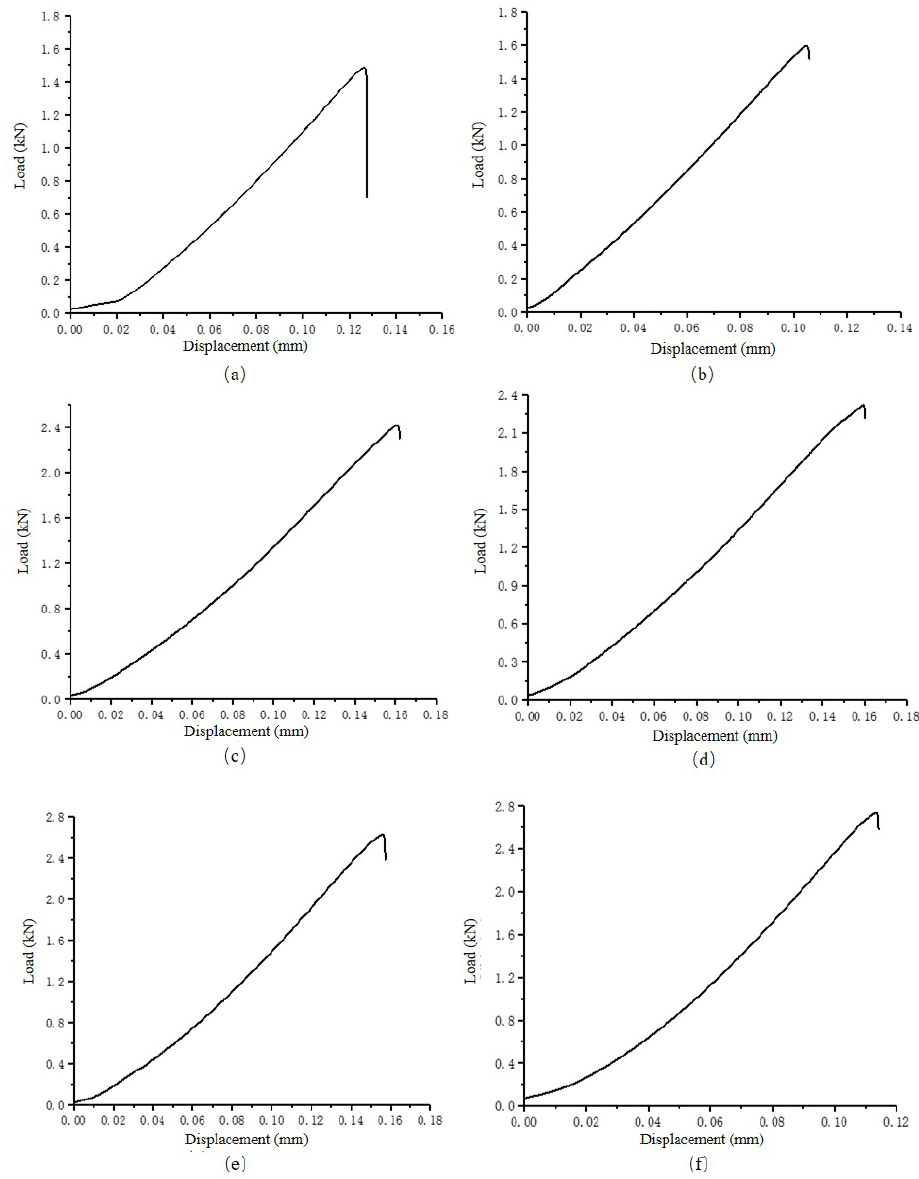
Figure 13. NSCB test load-displacement diagram of three modes of type-I fractures in shale: ( a ) for the splitter fracture of specimen S1, ( b ) for the splitter fracture of specimen S2, ( c ) for the arrester fracture of specimen A1, ( d ) for the arrester fracture of specimen A2, ( e ) for the divider fracture of specimen D1, ( f ) for the divider fracture of specimen D2.